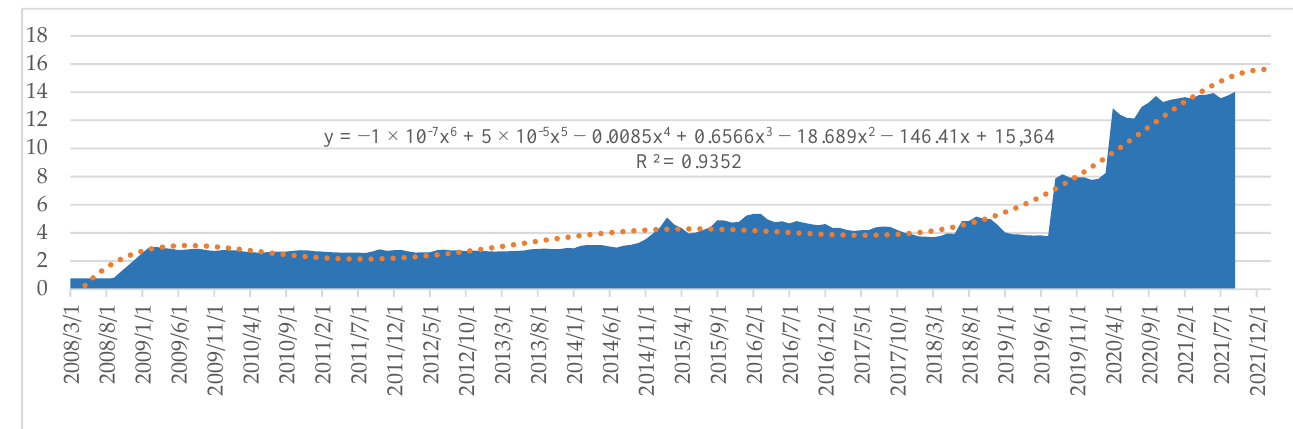
Figure 2. Dynamics of the NWF volume and trend line, trillion rubles. Source: compiled by the authors based on (Mishakov et al. 2021; Zvereva et al. 2020).